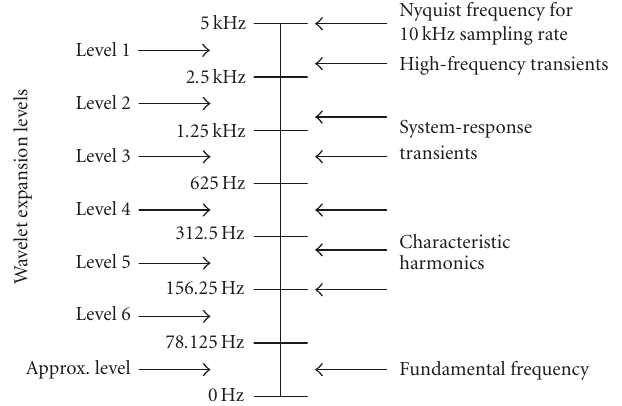
Figure 6: Frequency division of DWT filter for 10 kHz sampling